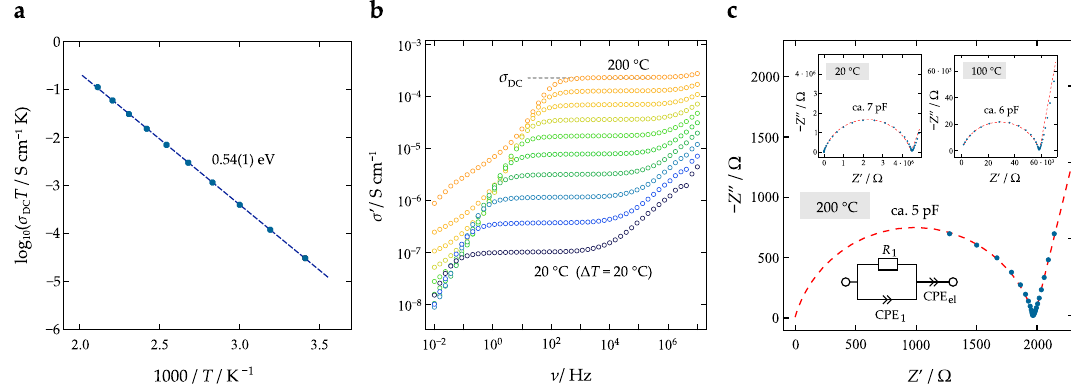
Figure 2. ( a ) Arrhenius Plot of the ionic conductivity σ DC multiplied with absolute temperature T vs. 1000/ T of nanocrystalline La 0.9 Ba 0.1 F 2.9 that was prepared by a mechanochemical approach. ( b ) Conductivity isotherms of La 0.9 Ba 0.1 F 2.9 starting from 20 ◦ C and ending at 200 ◦ C, which was the highest temperature where we measured conductivities. ( c ) Nyquist representation of the complex impedance data of La 0.9 Ba 0.1 F 2.9 ; the curve refers to a temperature of 200 ◦ C and shows the imaginary part of the complex impedance − Z (cid:48)(cid:48) plotted vs.the real part Z (cid:48) . The inset shows additionally the Nyquist representation at temperatures of 20 ◦ C and 100 ◦ C. The spike at low frequencies represents electrode polarization effects originating from the ion-blocking electrodes used. The whole location curve was parameterized with the equivalent circuit shown in the inset. It consists of a resistor R 1 connected in parallel to a constant phase element (CPE); this R 1 -CPE 1 element represents the overall (bulk) semicircle and leads to an associated capacitance C [32,33] of ∼ 5 pF, which is a typical value for electrical relaxation taking place in the interior regions of the grains [29]. Another CPE element, connected in series, was used to approximate electrode